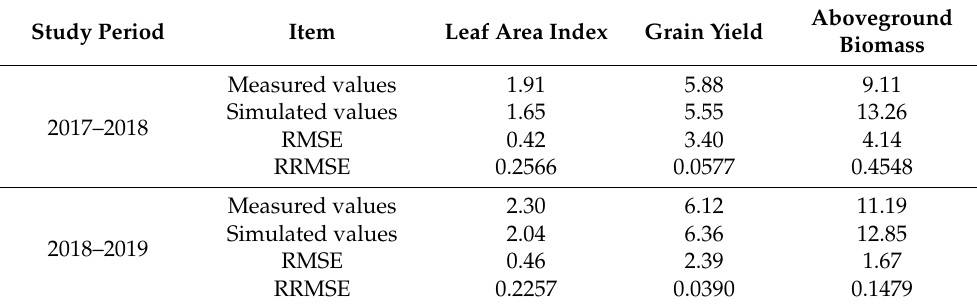
Table 2. Measured and simulated values of wheat leaf area index (cm 2 cm − 2 ), grain yield (Mg ha − 1 ) and aboveground biomass (Mg ha − 1 ) during wheat growth stages in